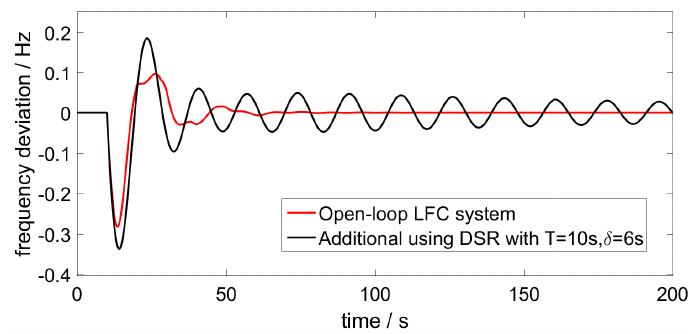
Figure 9. Frequency deviation under open-loop and close-loop LFC system in area